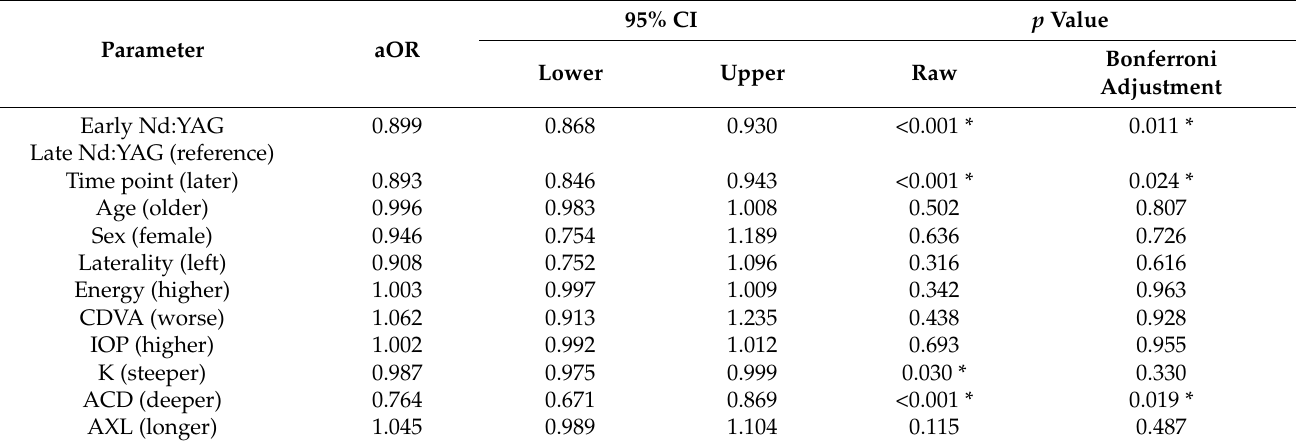
Table 5. The effect of different period of Nd:YAG on hyperopic change in spherical